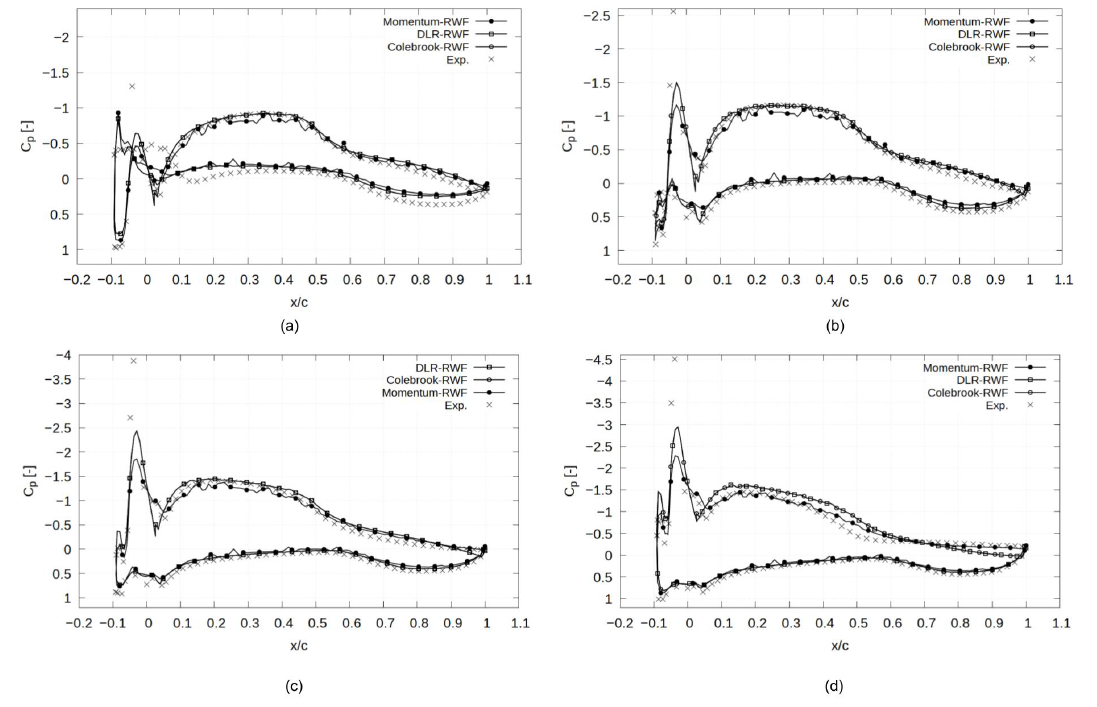
Figure 10. Case 1: C p distribution for AoA = ( a ) 0 ◦ , ( b ) 4 ◦ , ( c ) 8 ◦ , and ( d ) 12 ◦